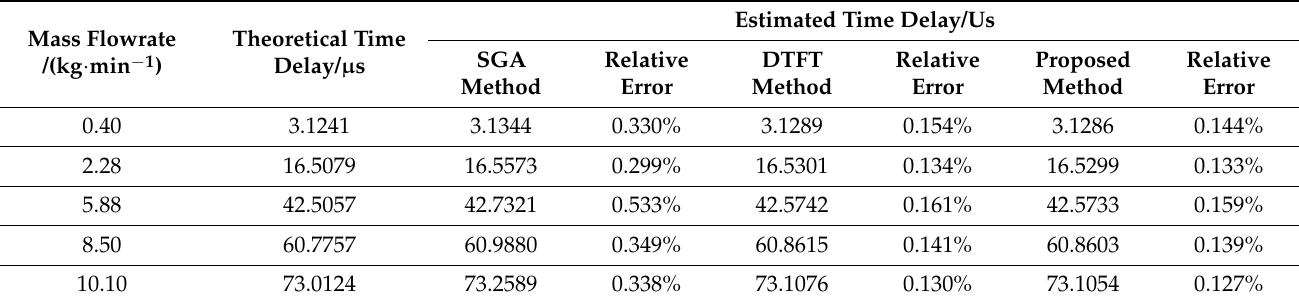
Figure 7. Estimation of phase difference at normal flowrate. Table 1. Theoretical versus estimated time delay at different flowrates.